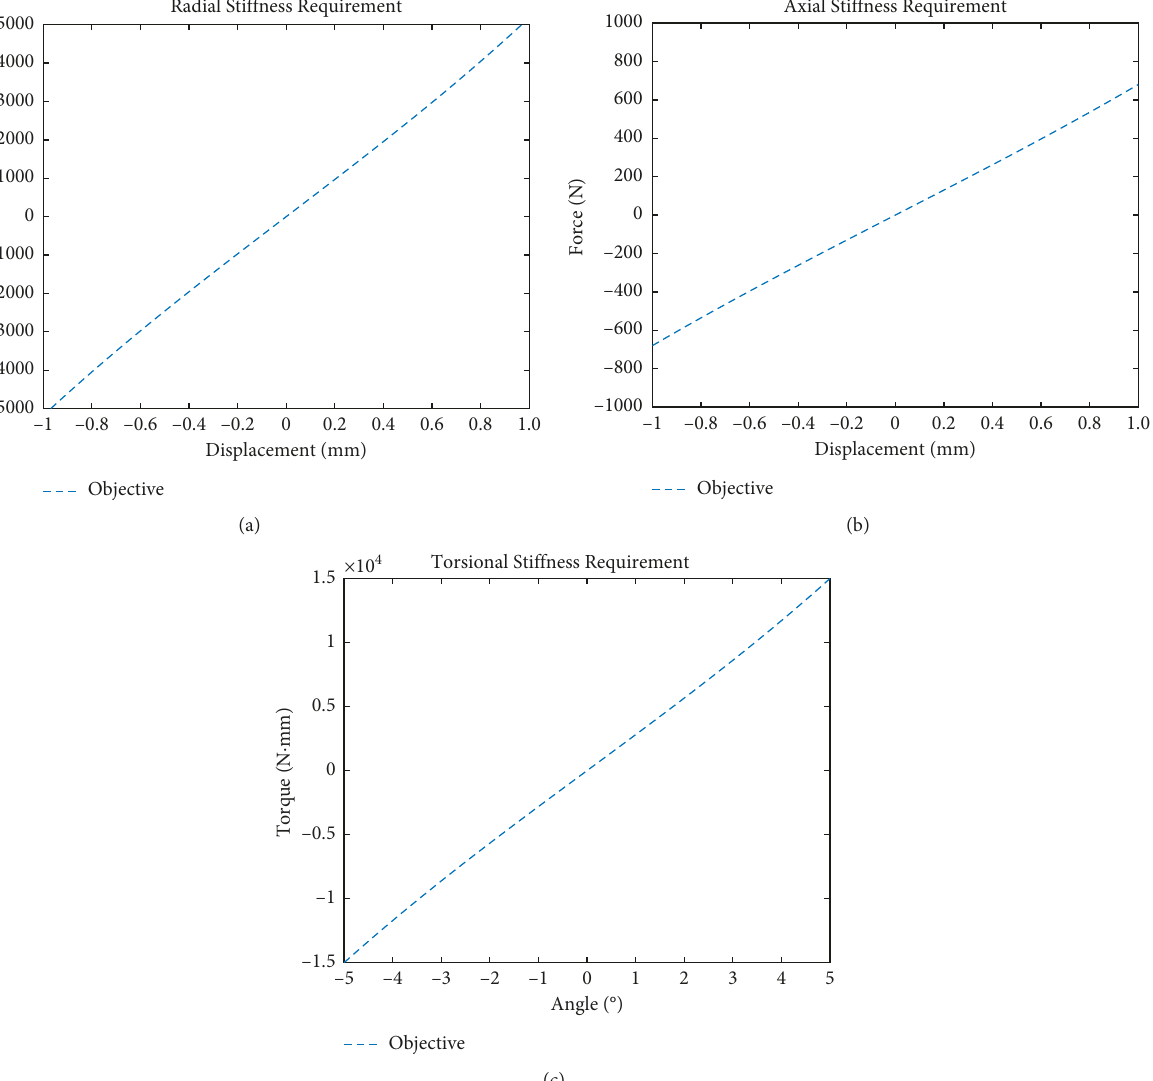
Figure 4: Characteristics curves in radial (a), axial (b), and torsional